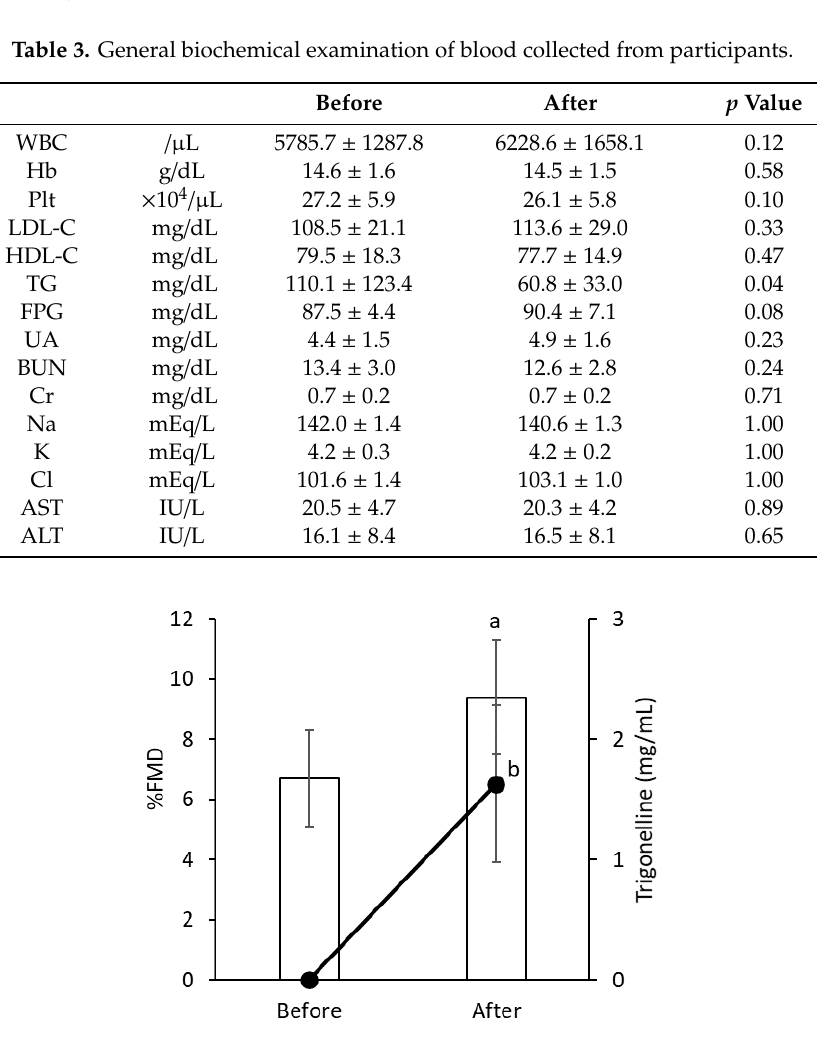
Figure 4. FMD levels (bar graph) and trigonelline concentrations (line graph) before and after consumption of Sakurajima radish for ten days. All values are represented as means ± SD. The means with a different letter are significantly different (a, difference in FMD level; b, difference in trigonelline concentration; p < 0.05 versus before).